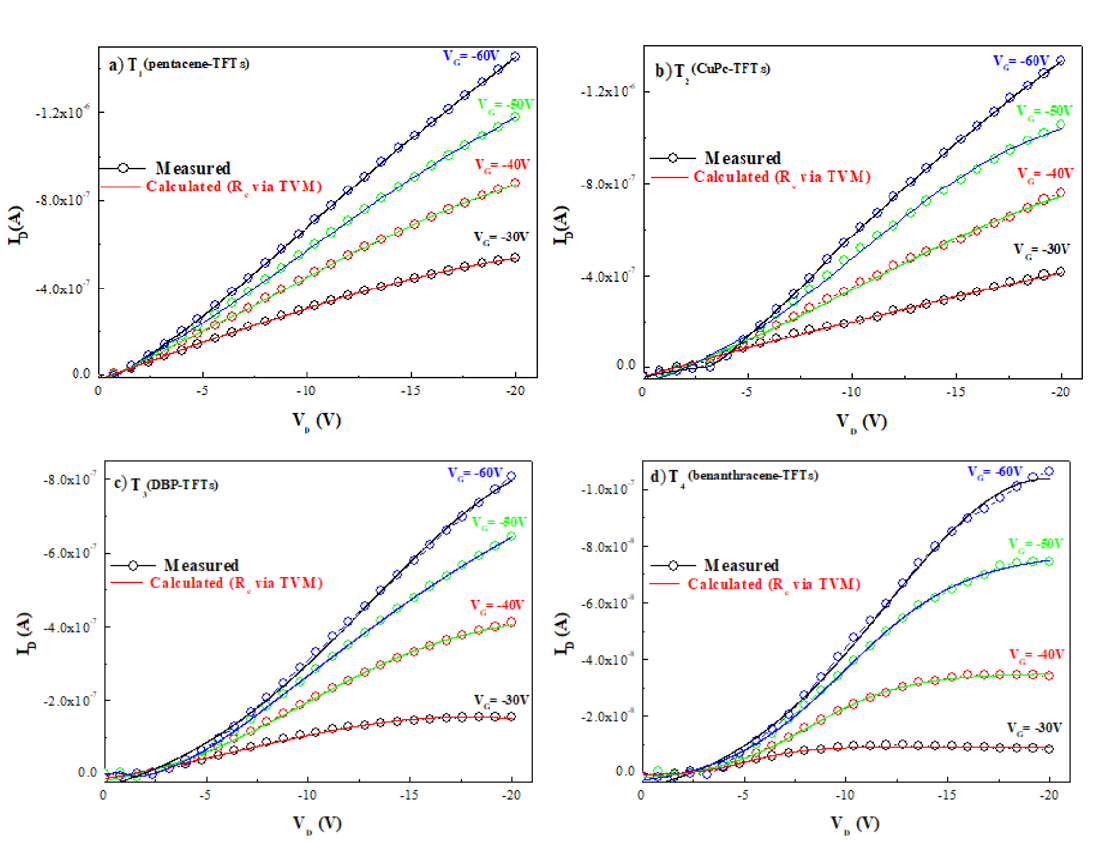
Figure 7. Comparison of the measured (circle) output characteristic curves in the linear regime and the calculated data including the extracted contact resistance using the transition voltage method of OTFTs based on various organic materials: ( a ) T1 (pentacene-TFTs), ( b ) T 2 (CuPc-TFTs), ( c ) T 3 (DBP-TFTs) and ( d ) T 4 (benzanthracene ‐ TFTs).